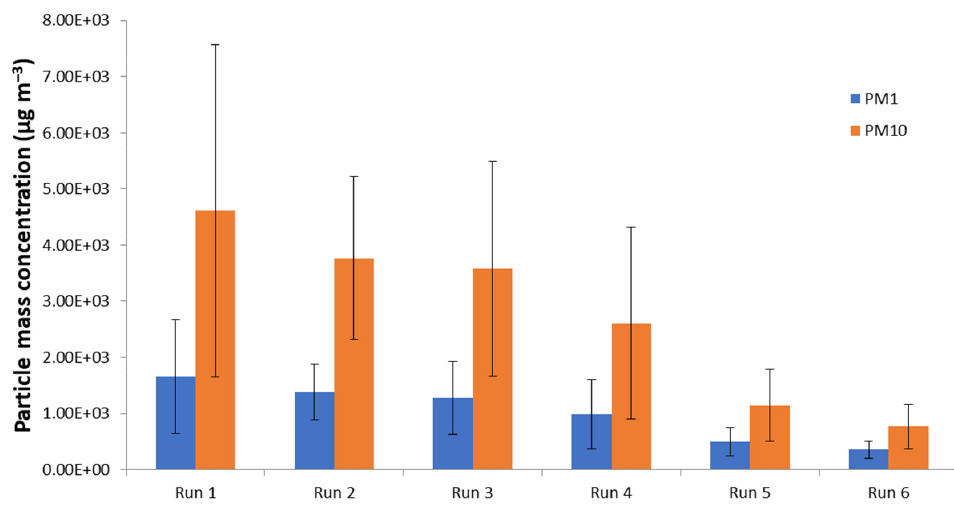
Figure 6. Averaged PM1 and PM10 particle mass concentrations for each test. Bars show particle mass concentration variability. Data collected by OPC SPS30 sensor.